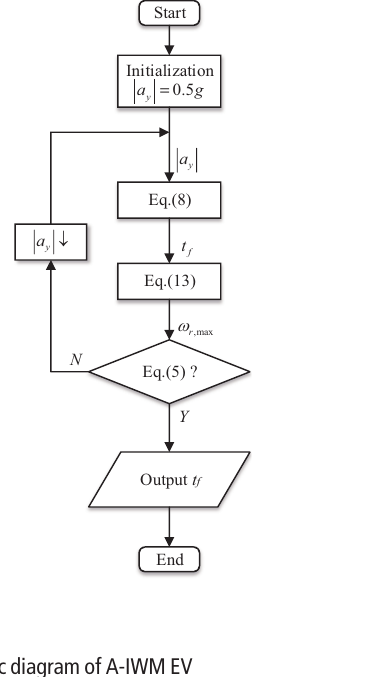
Figure 4 Schematic diagram of A-IWM